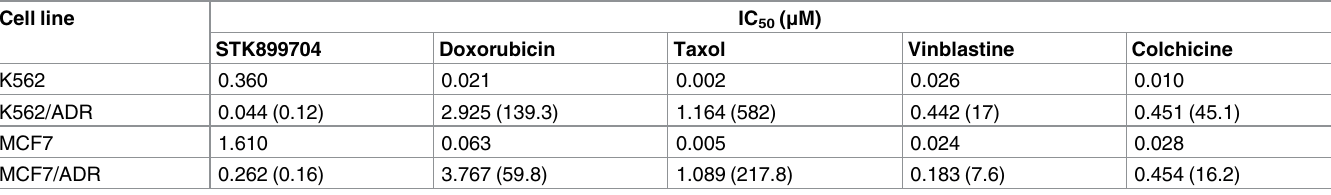
Table 1. Effect of STK899704, doxorubicin, Taxol, vinblastine, and colchicine on multidrug-resistant cell lines. Cell